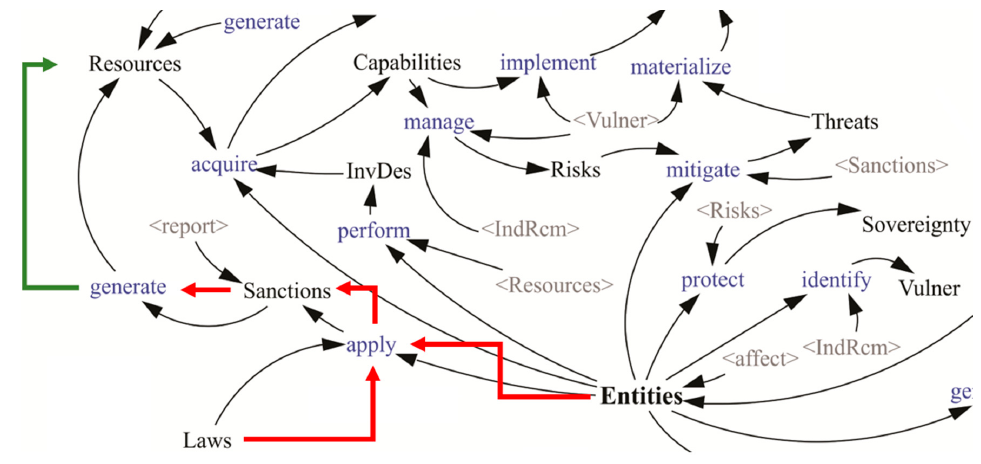
Figure 12. Design pattern.